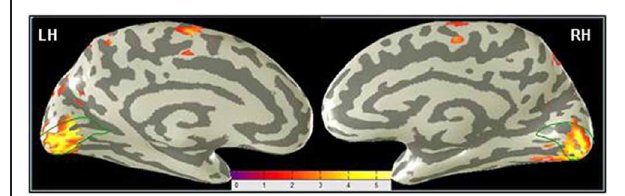
representations of the posterior left (LH) and right (RH) hemispheres, shows the increase (orange-yellow coloration) of the post -training BOLD activation in MD relative to the pre -training level. Dark gray, sulci; light gray,